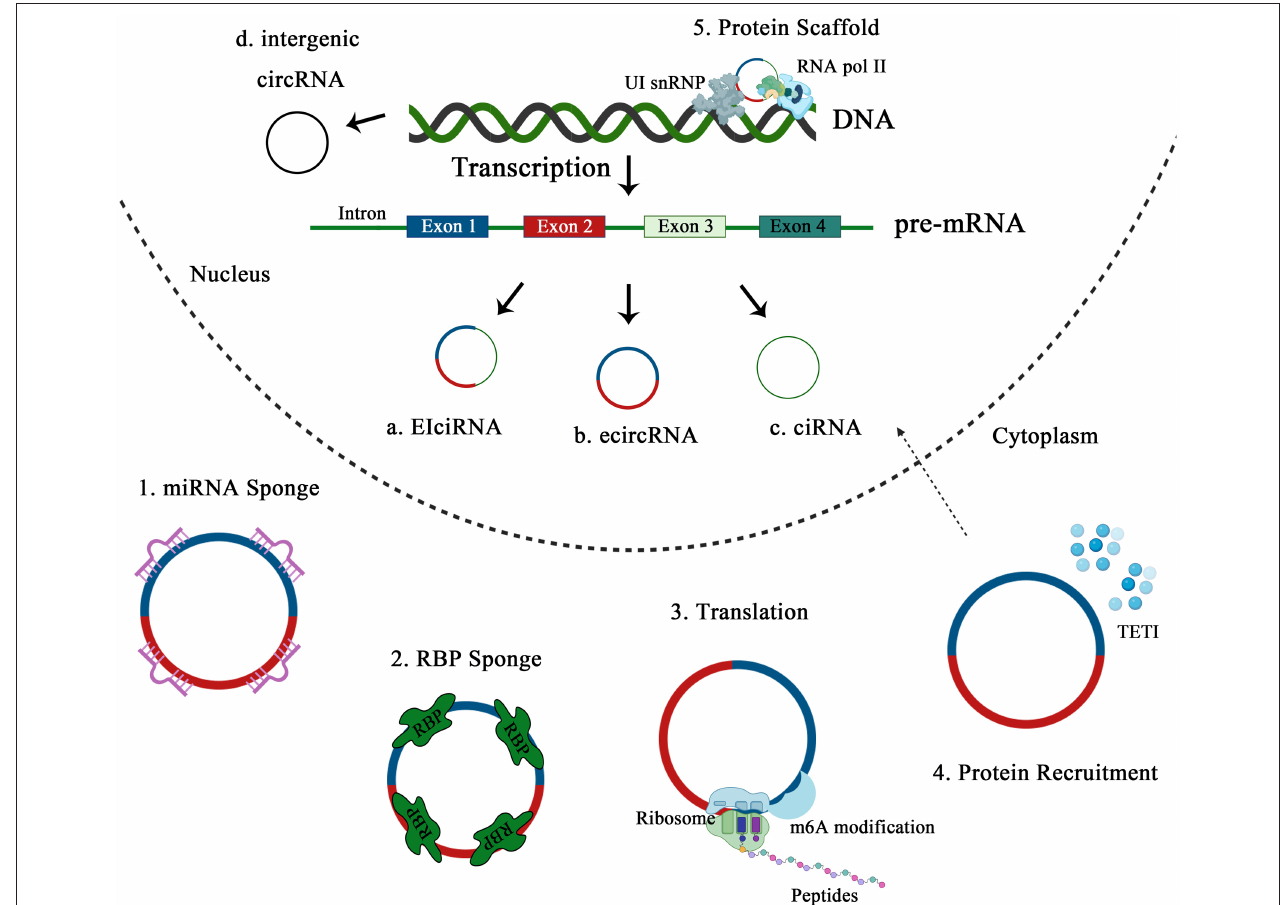
FIGURE 1 | Schematic diagram of the biogenesis and functions of